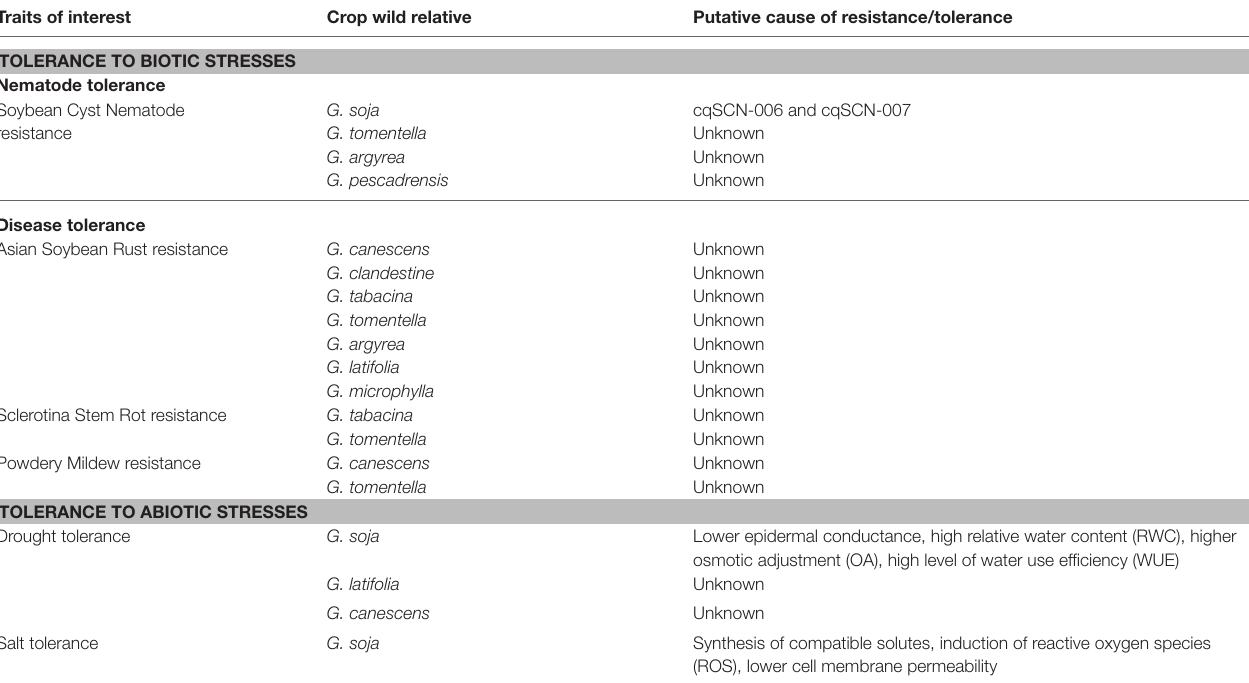
TABLE 4 | Summary of biotic and abiotic stress tolerance traits of wild relatives of cultivated soybean ( Glycine max ). Traits of interest Crop wild relative Putative cause of resistance/tolerance TOLERANCE TO BIOTIC STRESSES Nematode tolerance Soybean Cyst Nematode resistance